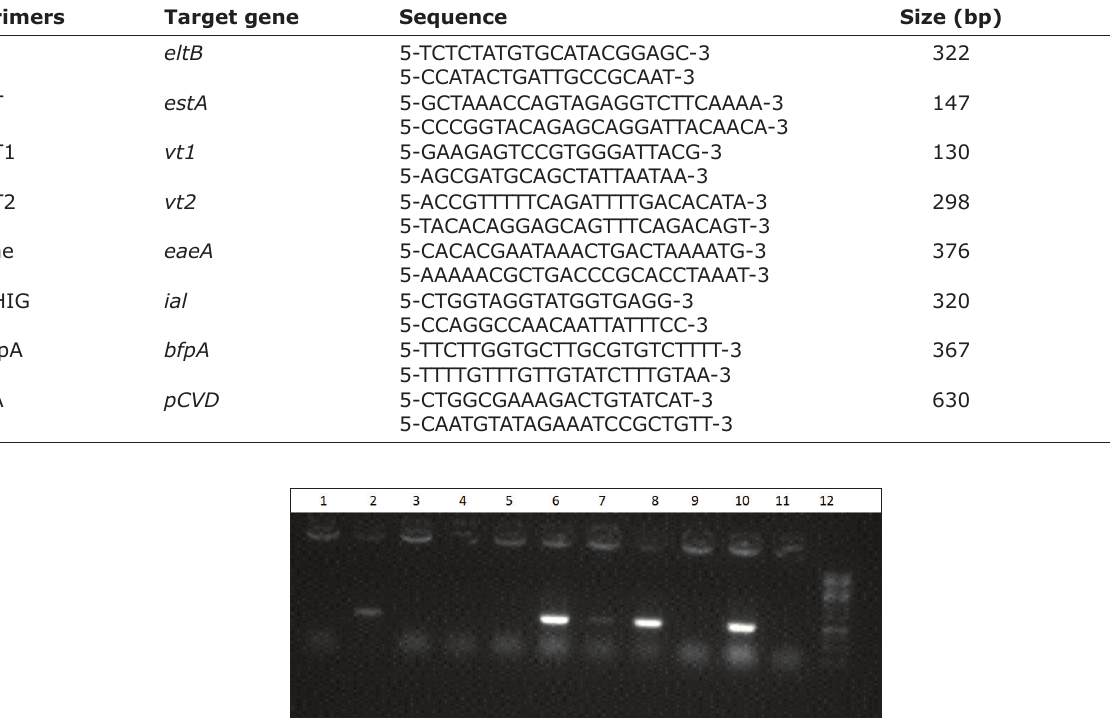
Table-S1: Primer characteristics used in the multiplex polymerase chain reaction.